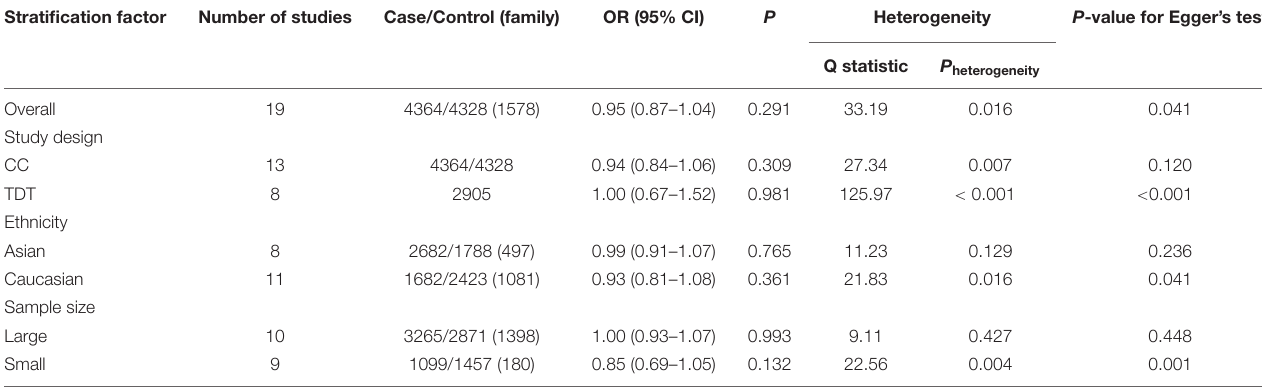
TABLE 3 | Meta-analysis for associations between BDNF Val66Met and ADHD.